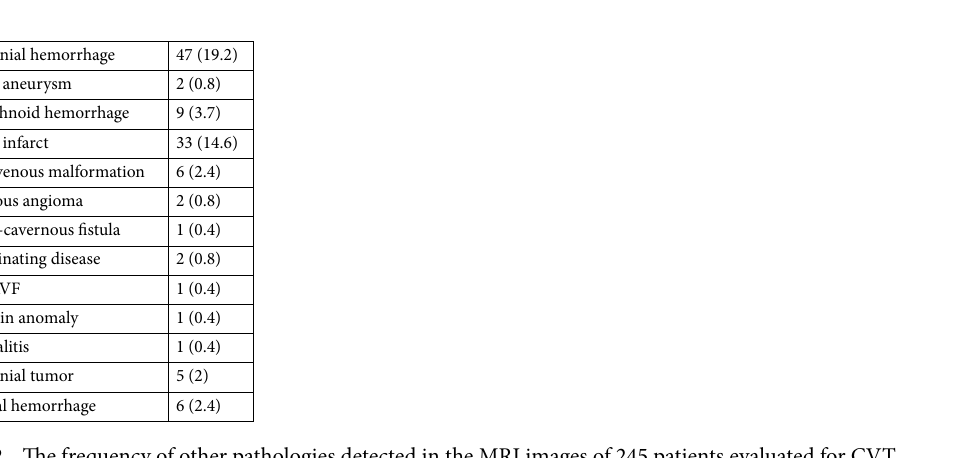
Table 2. The frequency of other pathologies detected in the MRI images of 245 patients evaluated for CVT. AVF arteriovenous